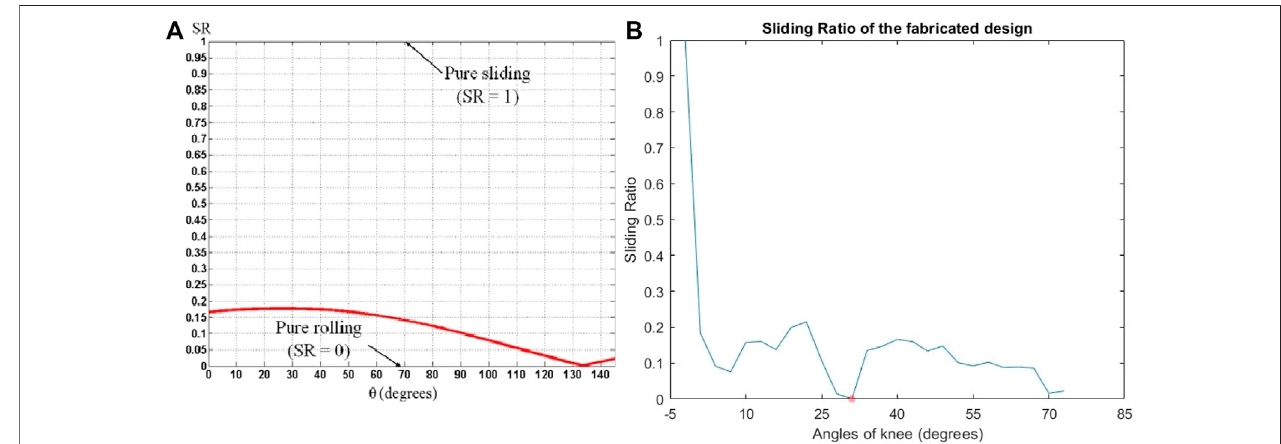
FIGURE 10 | (A) Sliding ratio of prototype knee joint (Etoundi et al., 2013b), (B) Sliding ratio of fabricated knee joint exoskeleton.